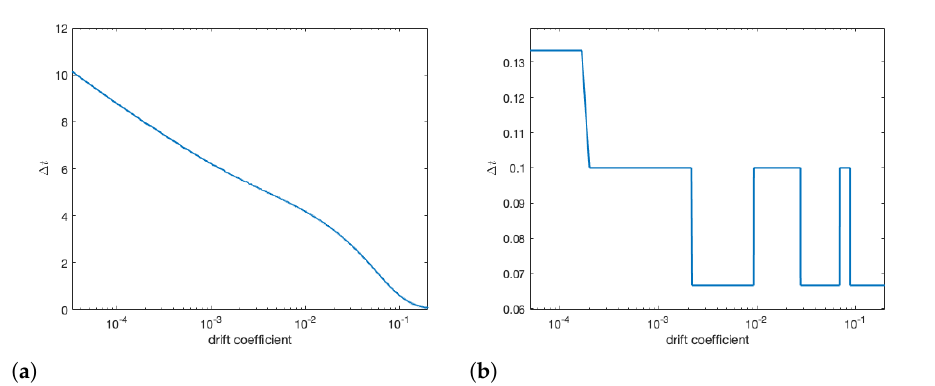
Figure 9. With all other parameters being equal, we change the drift coefficient and measure the time between peak infections in colony 1 and colony 2. We can see for low β (panel ( a )) that increasing the drift coefficient (i.e., decreasing the distance between colonies) exponentially decreases the time it take an infection to reach colony 2. When β is high (panel ( b )), we see that there is less importance on drift, it only need be present.